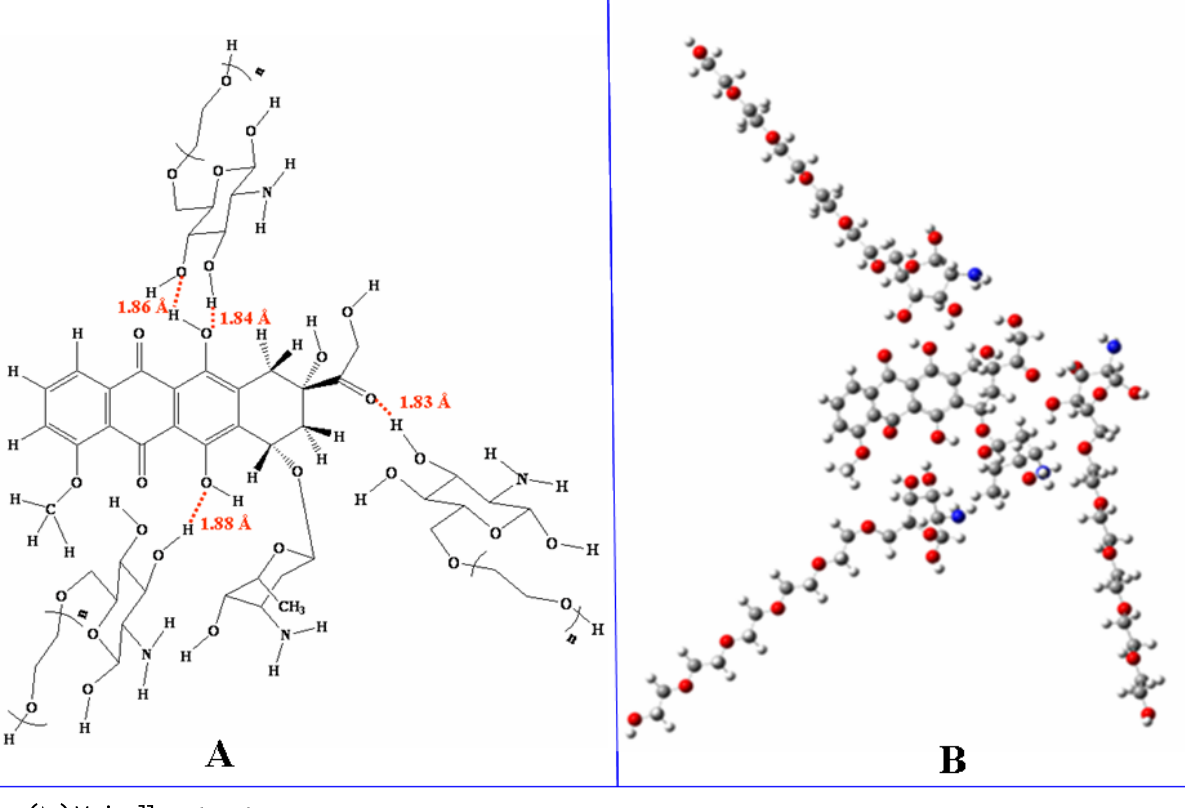
Figure 7. Simulated doxorubicin micelle using B3LYP/6-31G//PM3